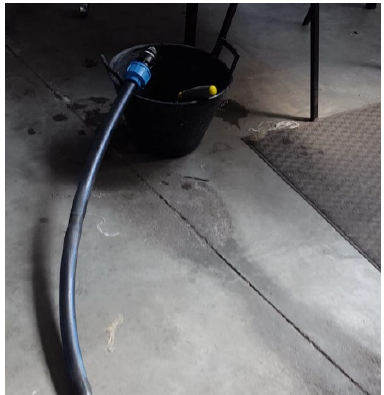
Figure 2. “ Sausage effect” during the pressurization hydraulic test.